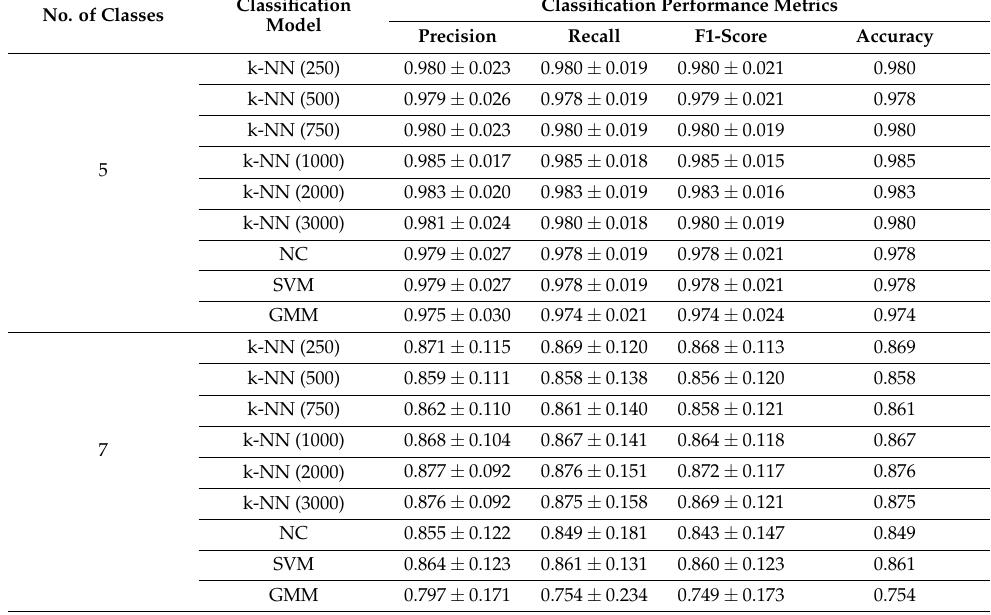
Table 6. Classification performance metrics for the models using the test dataset. The numbers in between parentheses indicate the number of neighbors used in the k-NN